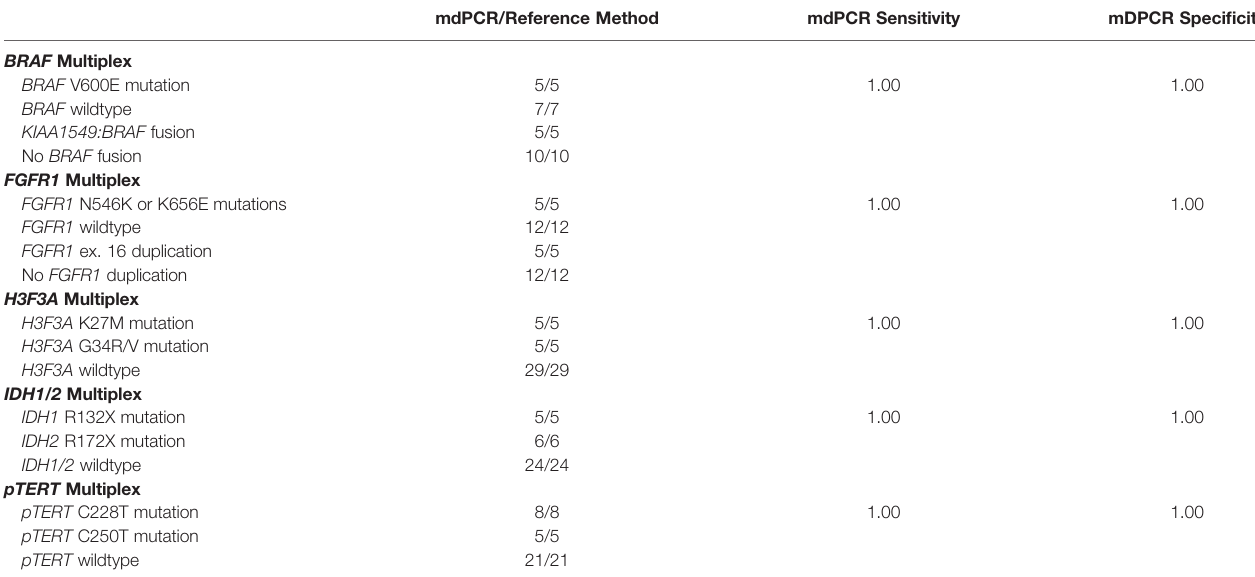
TABLE 1 | Results of the multiplexed digital PCR assays compared to reference